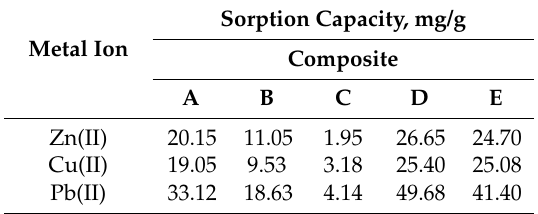
Table 6. The sorption capacity of PVC-acac composites after 4 h of sorption. Sorption Capacity, mg/g Metal Ion Composite